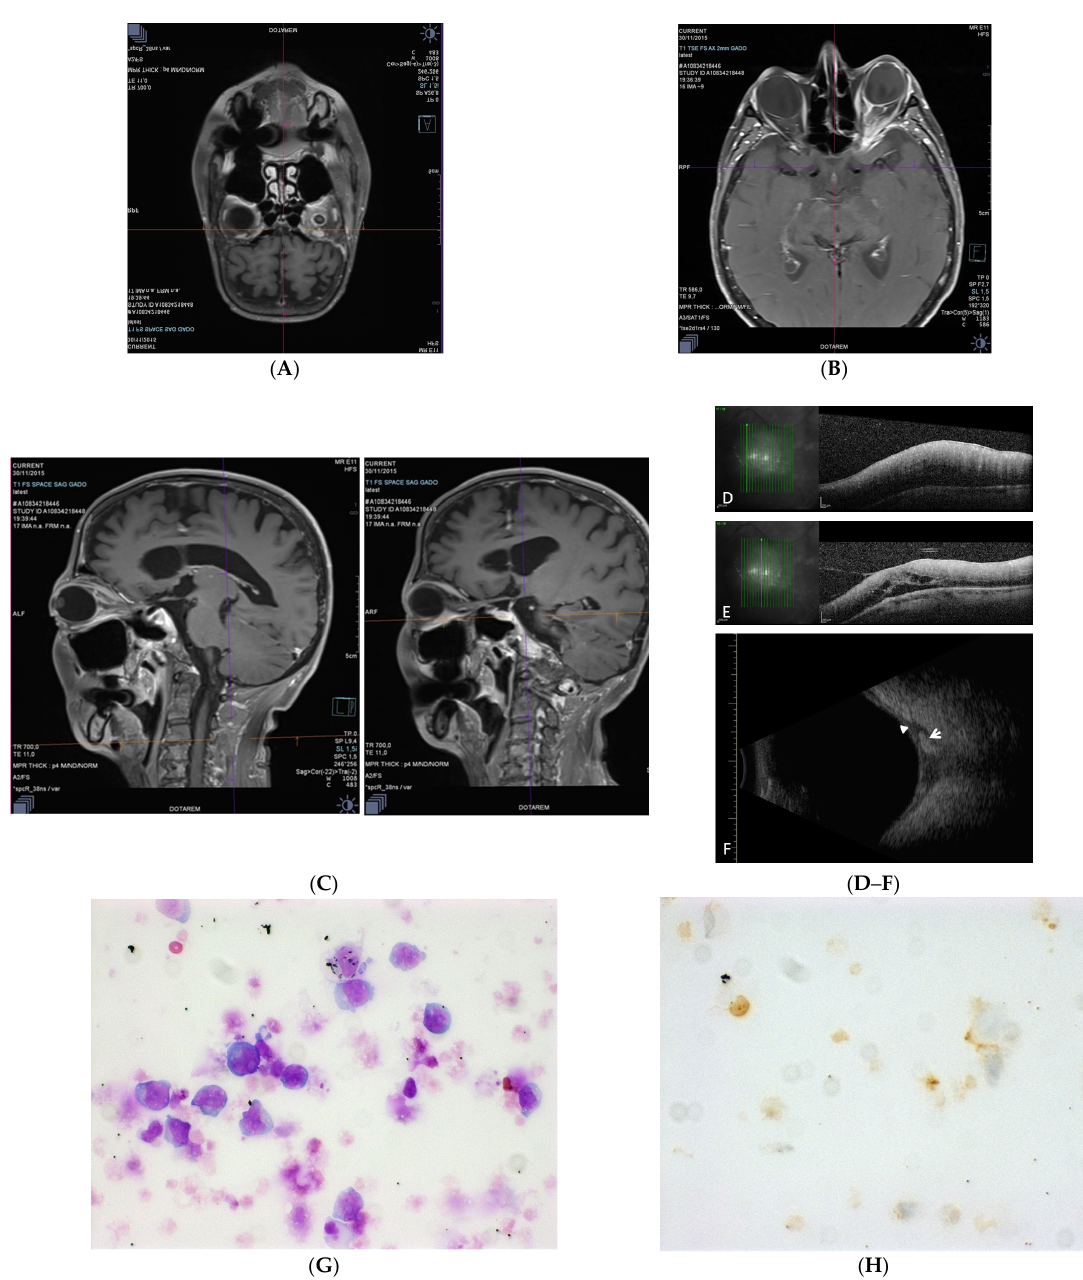
Figure 3. Case 3. Brain MRI. ( A ) Coronal postcontrast fat-suppressed T1-weighted image passing through the orbits and showing rostral peri- and intra-optic nerve enhancement on the left side; ( B ) Axial postcontrast fat-suppressed T1-weighted image passing through the orbits and showing cho- roidoscleral and perioptic meningeal enhancements extending to the adjacent orbital fat on the left side; ( C ) Oblique sagittal postcontrast fat-suppressed T1-weighted image showing the whole left optic nerve, whose meninges are strongly enhanced in the intral conal space (on the right) compared with the right optic nerve (on the left); ( D ) SD-OCT (Heidelberg) showing thickened retina (inner and outer retina); ( E ) SD-OCT (Heidelberg) showing foveal intraretinal cysts and subretinal fluid; ( F ) B-scan ultrasonography revealed left optic nerve thickening in shell appearance in two parts; one focal hyper-reflective part (white arrow) surrounded by a hypo-reflective, exudative area (white arrow head). Vitreous sample; ( G ) Atypical lymphocytes, large cells with large vesicular nuclei, nucleolated with basophilic cytoplasma (May-Grünwald Giemsa, 400×); ( H ) The lymphoid cells are identified as CD20+ (CD20, 400×).